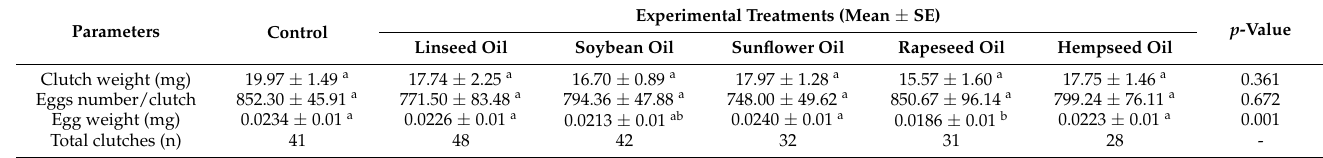
Table 2. The effects of vegetable oil addition in the larvae rearing diets on the reproductive perfor- mances of Hermetia illucens .